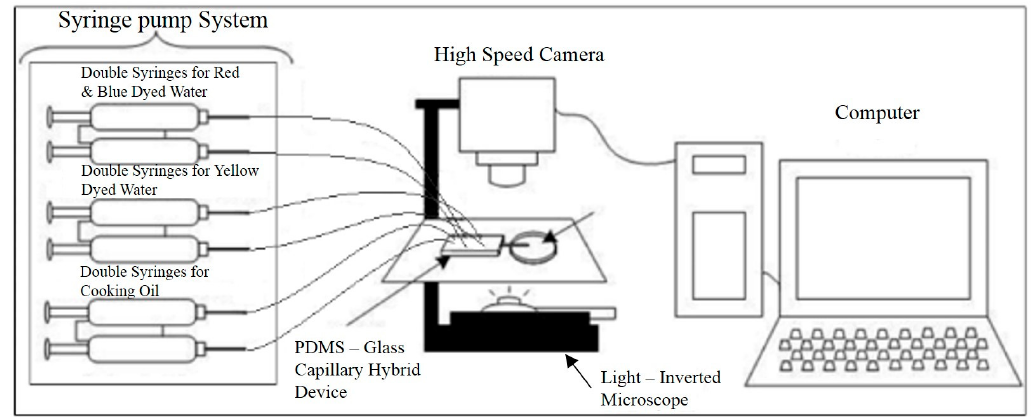
Figure 2. Schematic diagram of the experimental setup for droplet encapsulation and fission.